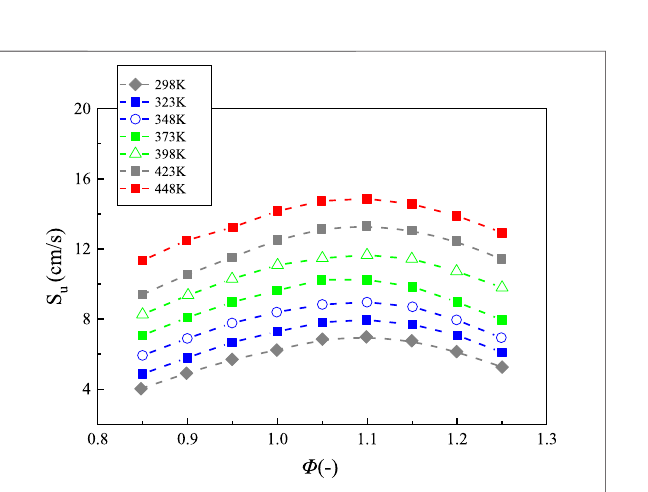
initial pressure from 0.3 to 1.6 atm, covering equivalence ratios from 0.5 to 1.3 and at 298 K. The measured laminar burning velocities of NH 3 fl ame fi rstly increased slightly and then decreased with the increasing pressure. The burning velocity of stoichiometric fl ame reaches the peak value at 0.5 atm. The maximum values exist at 0.7 atm when the equivalence ratio is 0.5